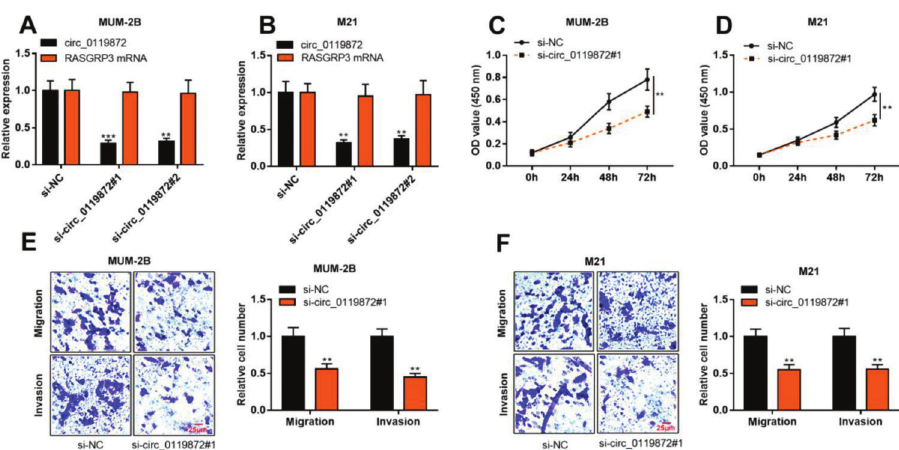
Figure 2 - Knockdown of circ_0119872 remarkably represses the proliferation, migration, and invasion of MM cells. (A,B) qRT-PCR was used to detect the circ_0119872 and RAS guanyl releasing protein 3 (RASGRP3) mRNA expression levels in MUM-2B and M21 cells after transfection with circ_0119872 small interfering RNA (siRNA). (C,D) The cell counting kit 8 (CCK-8) assay was performed to detect the proliferation of MUM-2B and M21 cells after transfection with circ_0119872 siRNA. (E,F) Transwell experiments were performed to detect the migration and invasion of MUM-2B and M21 cells after transfection with circ_0119872 siRNA. ** p o 0.01 and *** p o (Figure 2E, F). The above data implied that circ_0119872 could regulate the malignant phenotypes of MM cells.